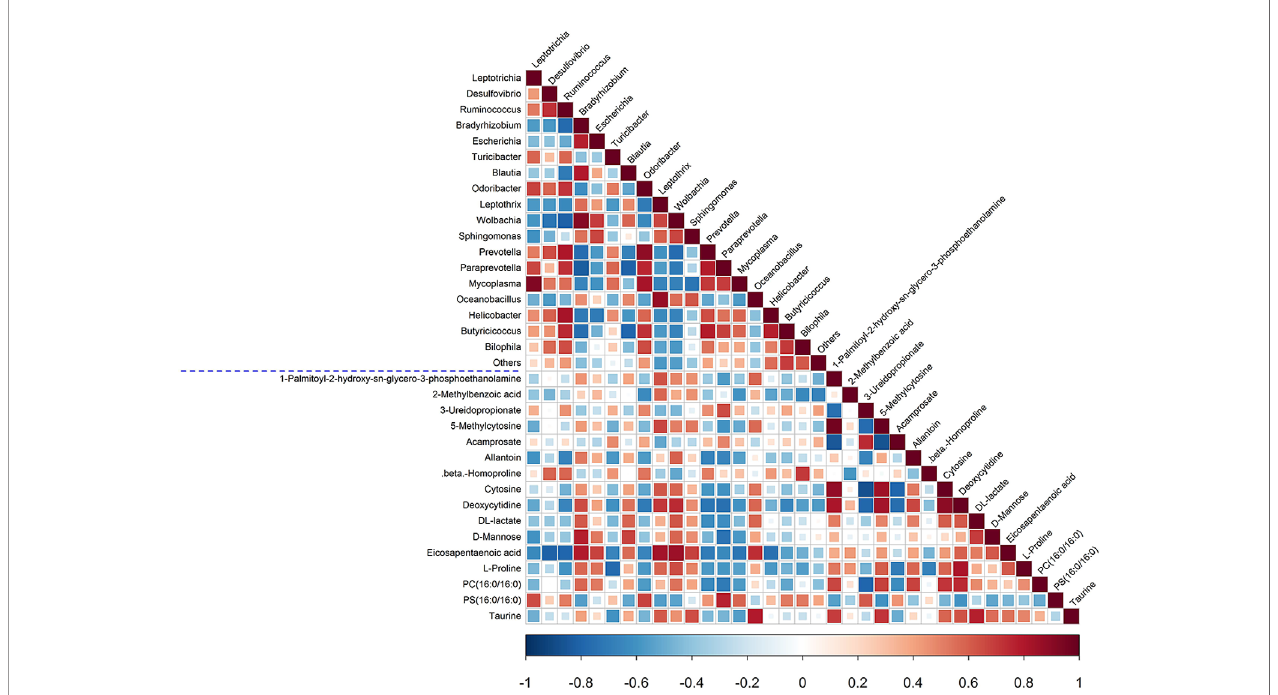
FIGURE 7 | Spearman correlation analysis of fecal microbiota and plasma metabolites. The p-values are depicted in blue and red, where red represents a positive correlation and blue represents a negative